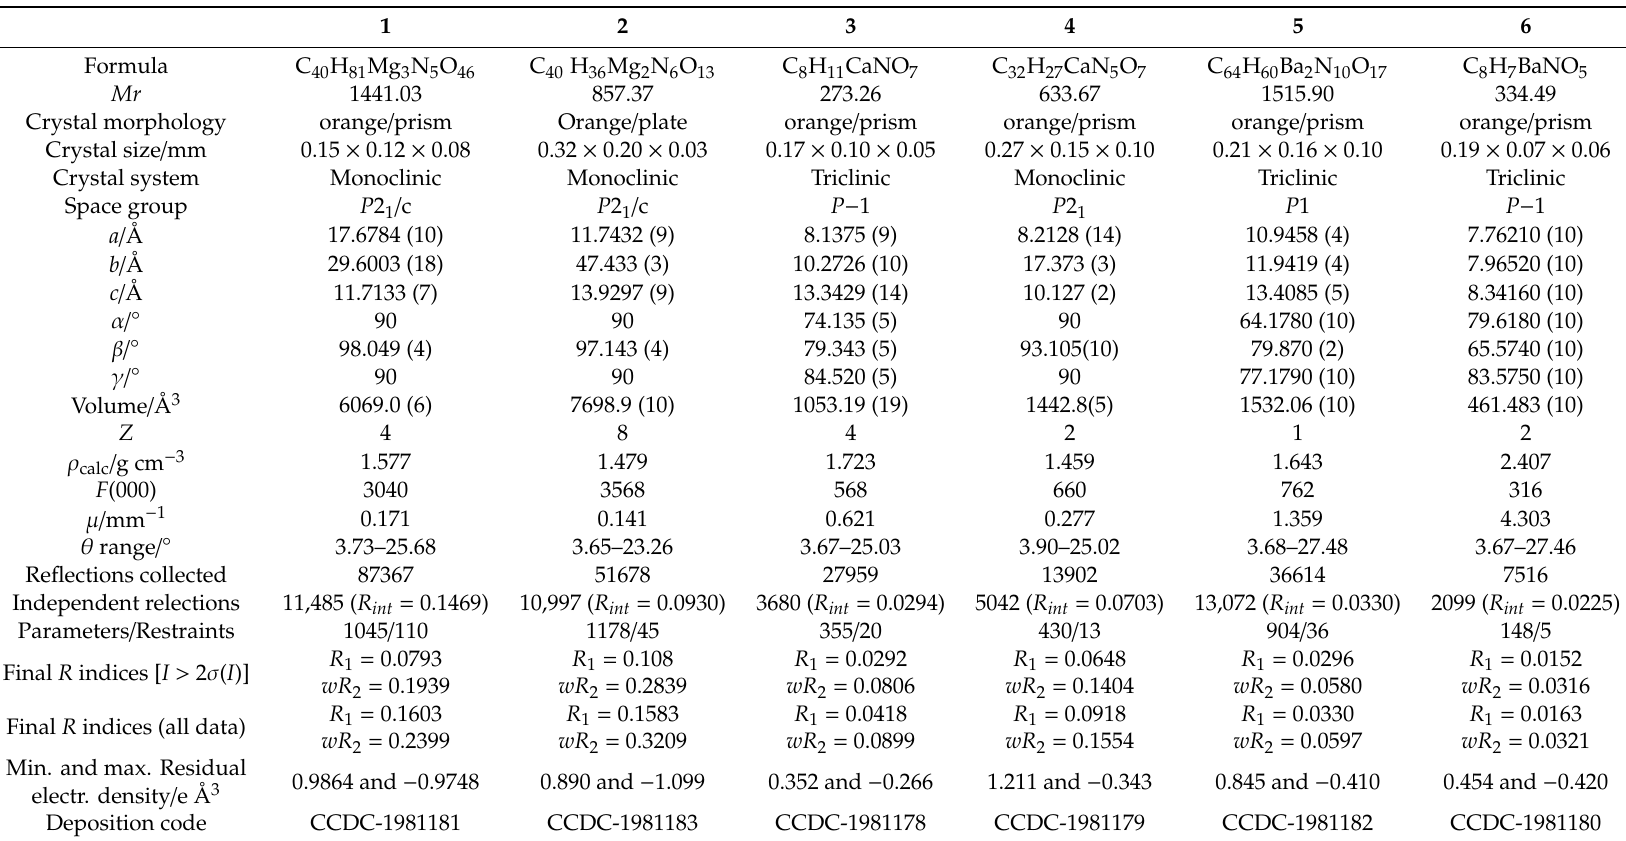
Table 2. Crystal data collection and refinement details for [Mg(H 2 O) 6 ] · [Mg 2 (Haip)(H 2 O) 10 ] · (Haip) · 3(aip) · 10(H 2 O) ( 1 ), [Mg(aip)(phen)(H 2 O) 2 ] · (H 2 O) ( 2